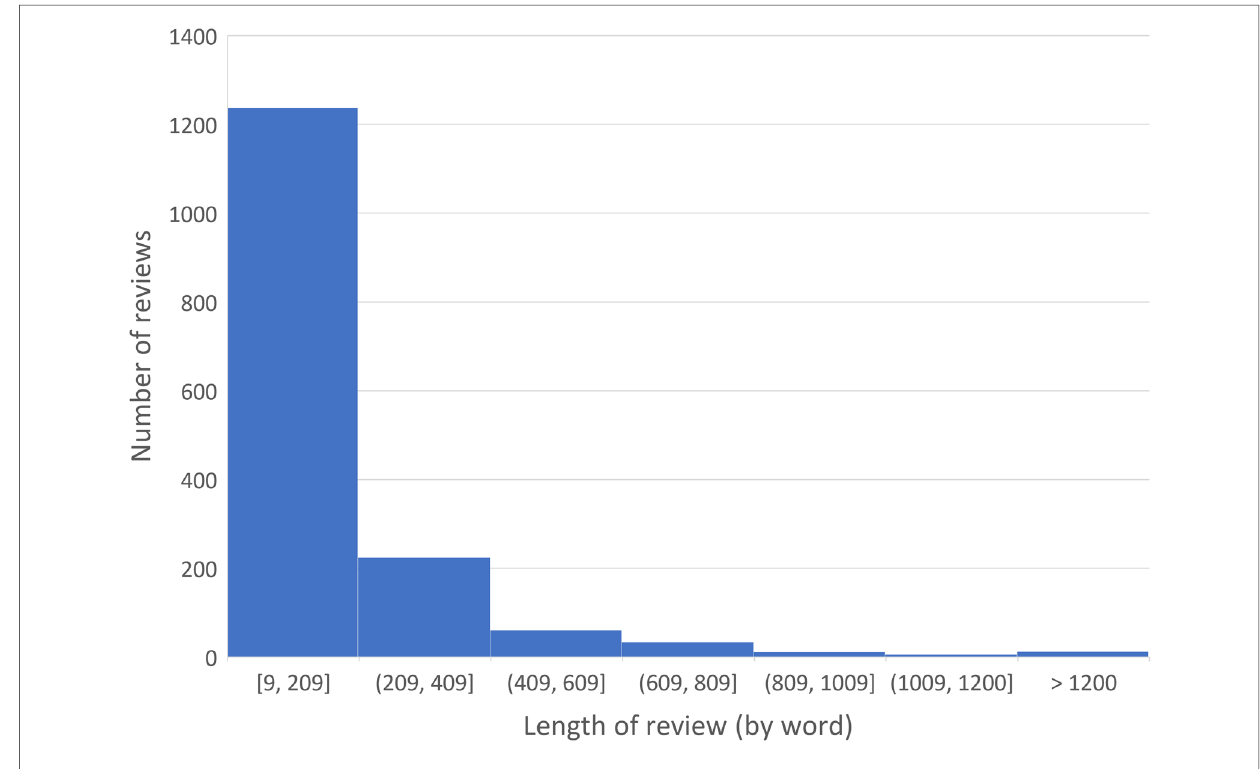
FIGURE 1 Distribution of the length of the reviews by the number of